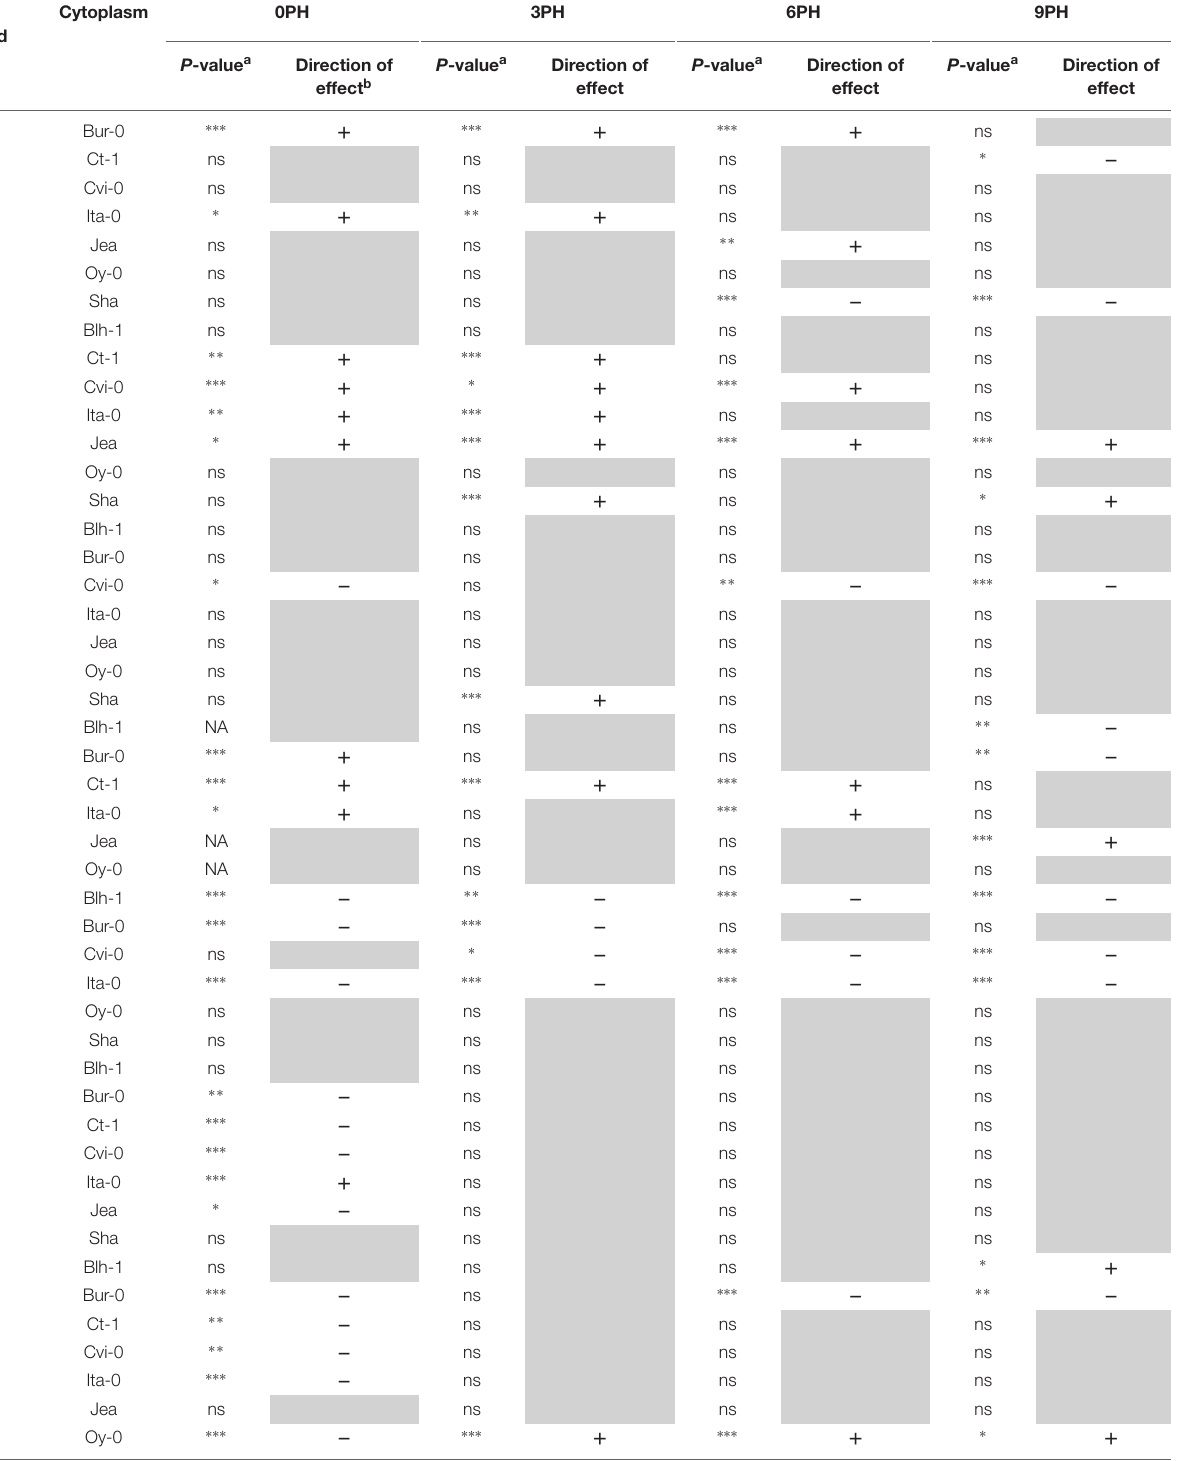
TABLE 1 | Impact of foreign cytoplasms on germination after various post-harvest times in the different nuclear backgrounds. Nuclear background